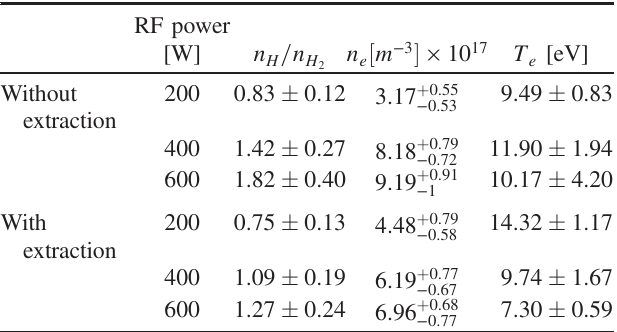
TABLE I. Plasma parameters with and without beam